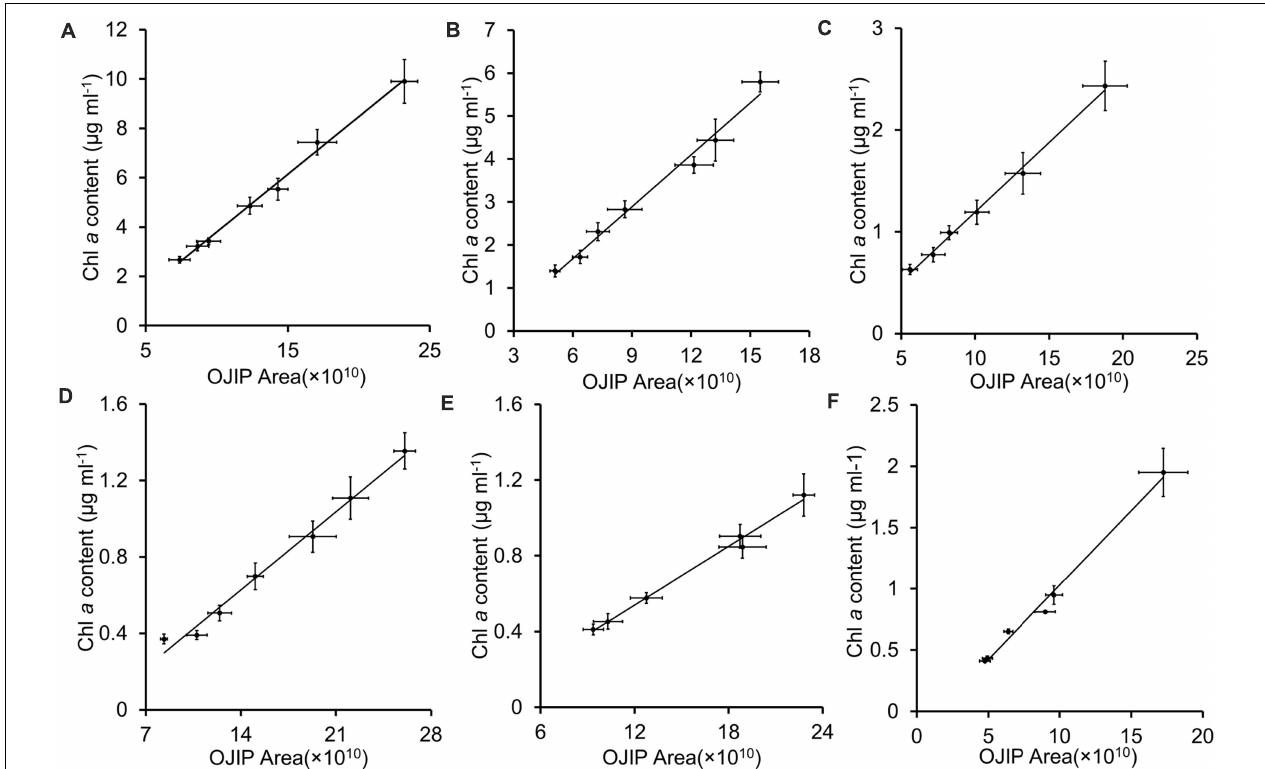
FIGURE 1 | The integral area of the OJIP curve–Chl a content linear fits for five representative algal strains and their mixed culture. (A) Chlamydomonas reinhardtii CC 4533; (B) Chlamydomonas reinhardtii CC 125; (C) Chlorella sp. C2; (D) Synechococcus PCC 7942; (E) Synechocystis PCC 6803; (F) Mixed culture of five algal strains. Each point represents a sample from a different time point in each culture’s growth curve. TABLE 2 | The integral area of the OJIP curve – Chl a content, cell density, or primary productivity correlation equations of pure cultured algae, mixed culture, or natural water (Wuhan). Algae strain Integral area (x) – Chl a content (y) Integral area (x) –cell density (y) Integral area (x) –primary productivity (y) Correlation equations R 2 Correlation equations R 2 Correlation